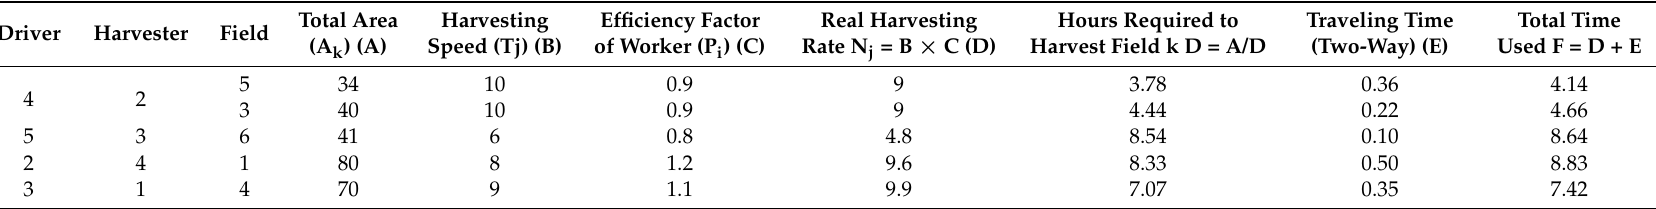
Table 6. Results of calculating hours required to execute the plan.